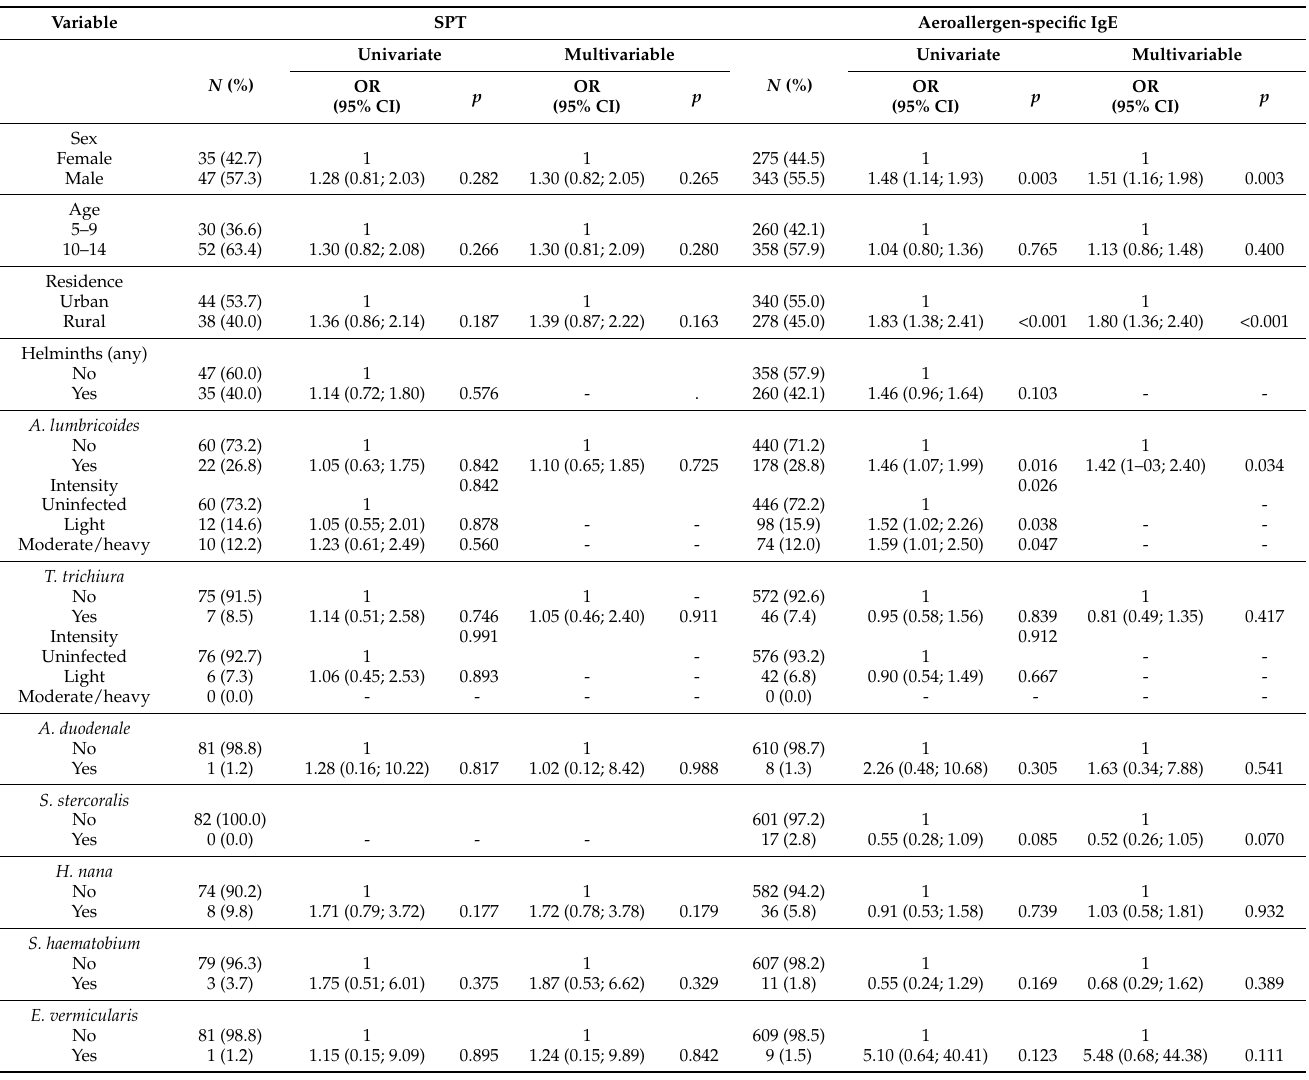
Table 4. Univariate and multivariable analyses for